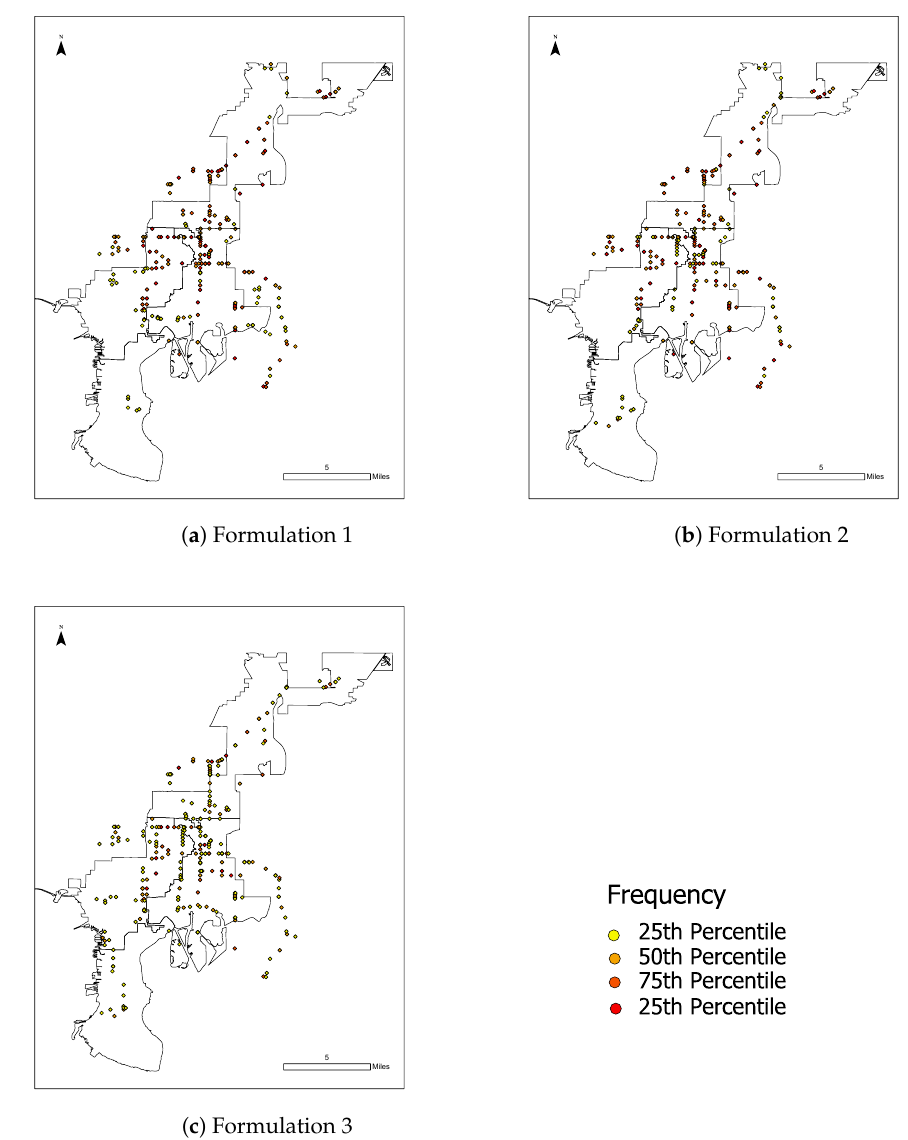
Figure 7. Maps of identified valves using the three formulations, where formulation 1 is deterministic, formulation 2 accounts for uncertainty, and formulation 3 accounts for uncertainty and likelihood of